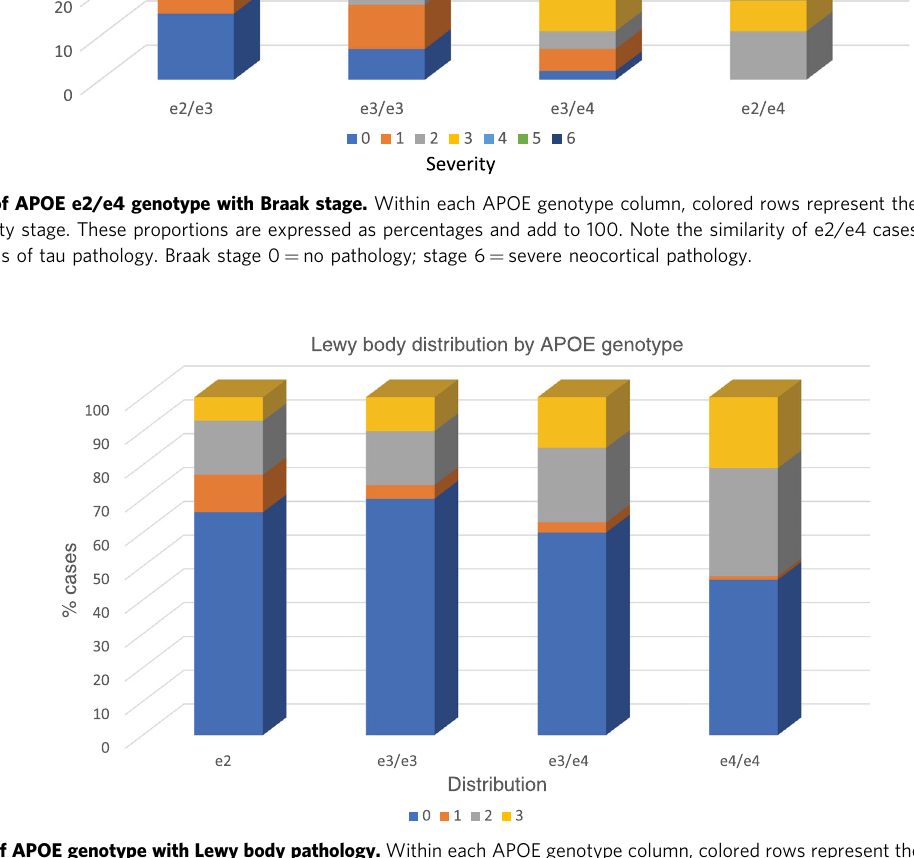
Fig. 4 Association of APOE genotype with Lewy body pathology. Within each APOE genotype column, colored rows represent the relative proportion of cases in each severity stage. These proportions are expressed as percentages and add to 100. Note the high proportion of e4 cases with limbic and neocortical pathology and the paucity of e4 cases with pathology restricted to the midbrain. Lewy body stage 0 = no pathology; stage 1 = midbrain; stage 2 = limbic; stage 3 =